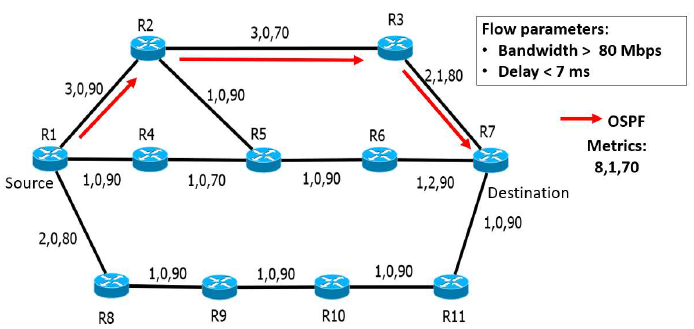
Figure 1. Traditional routing. Metrics: delay (ms), packet loss (%), and bandwidth (Mbps).